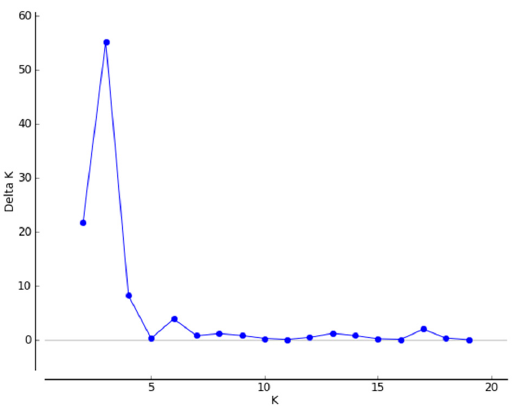
Figure 3. Relationships between the number of clusters ( K ) and the corresponding Δ K statistics calculated according to Δ K based on STRUCTURE analysis [46].